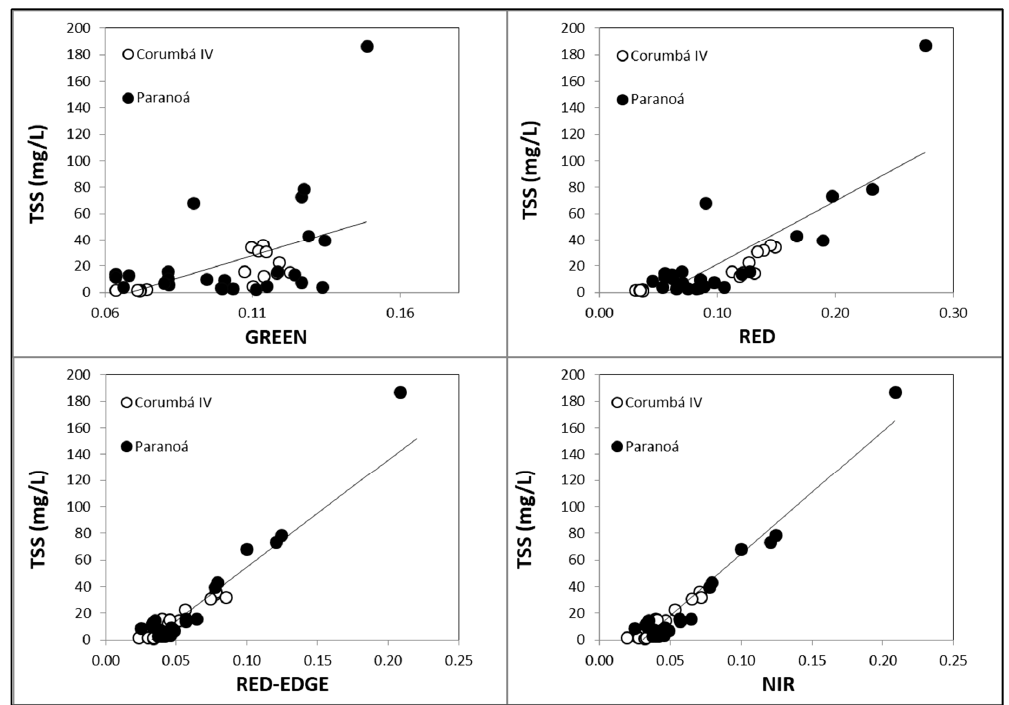
Figure 9. Scatter plots of all Sequoia bands and the total suspended solids (TSS) concentrations in study areas, Corumbá IV and Paranoá .